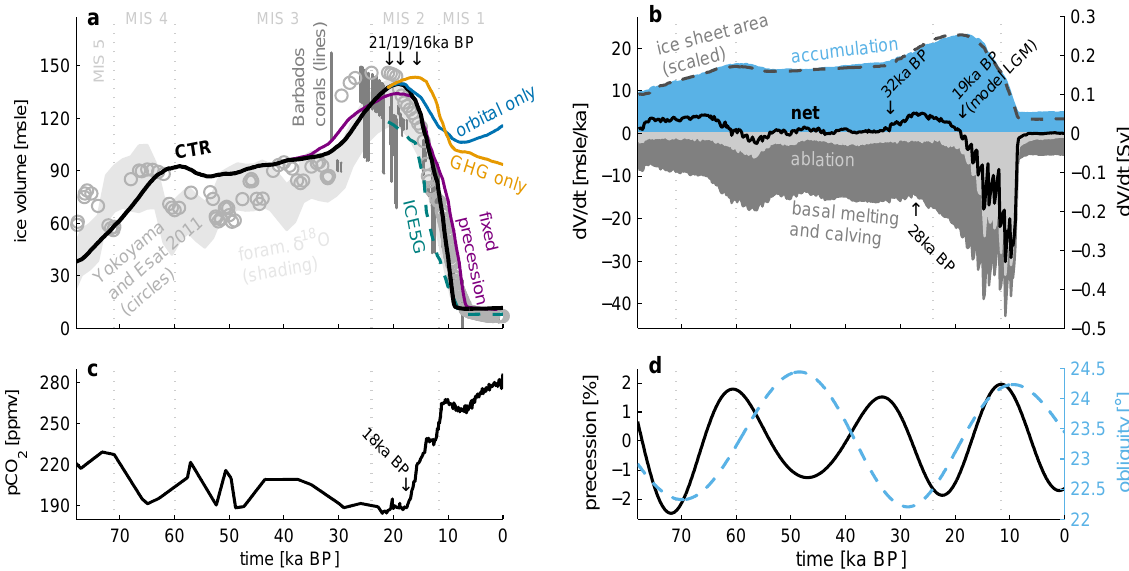
Figure 2. Ice sheet evolution, mass balance, and forcing. (a) Simulated Northern Hemisphere (NH) ice sheet volume in meters sea level equivalent (ms.l.e.) for a run with orbital and GHG forcing (control run CTR, thick black), only GHG forcing (orange, fixed 21kaBP orbit), only orbital forcing (blue, fixed 21kaBP GHGs), and fixed precession (purple, eccentricity and longitude of perihelion fixed at 40kaBP, obliquity and greenhouse gases vary as in CTR). Reconstructed NH ice volume (Peltier, 2004, ICE-5G, teal dashed line), and reconstructed global sea level changes from Barbados coral records (Peltier and Fairbanks, 2006, vertical gray lines), from benthic foraminifera oxygen isotope records (Waelbroeck et al., 2002, light gray shading indicates confidence interval), and from coral terraces at Huon Peninsula, Papua New Guinea (Yokoyama and Esat, 2011, gray circles). (b) Ice volume rate of change due to accumulation (blue area), ablation (light gray area), basal melting and calving (dark gray area), and their balance (net, thick black line) from CTR. Dashed gray line indicates the simulated NH ice sheet area scaled by max(accumulation)/max(area). (c) CO 2 forcing (Lüthi et al., 2008). (d) Precession index (black line, high values indicate NH summers closer to the sun), and obliquity (Berger, 1978, dashed blue line). The dotted gray vertical lines indicate boundaries between marine isotope stages (MIS).